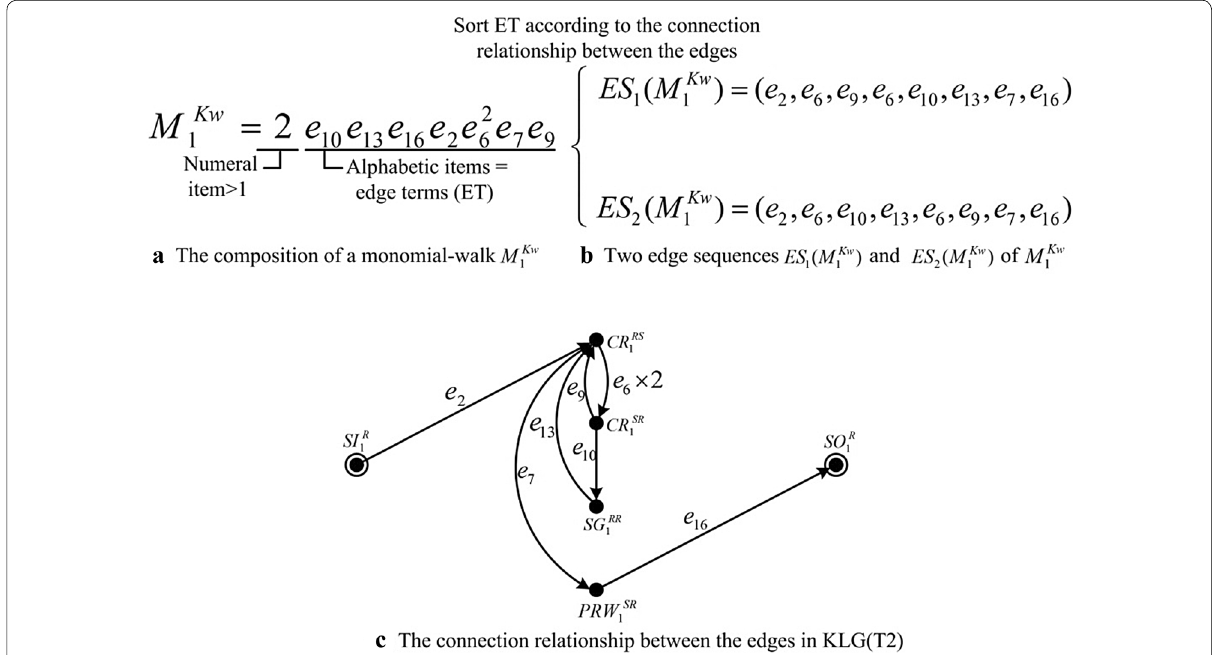
Figure 6 Composition of monomial-walk M Kw 1 and its two edge